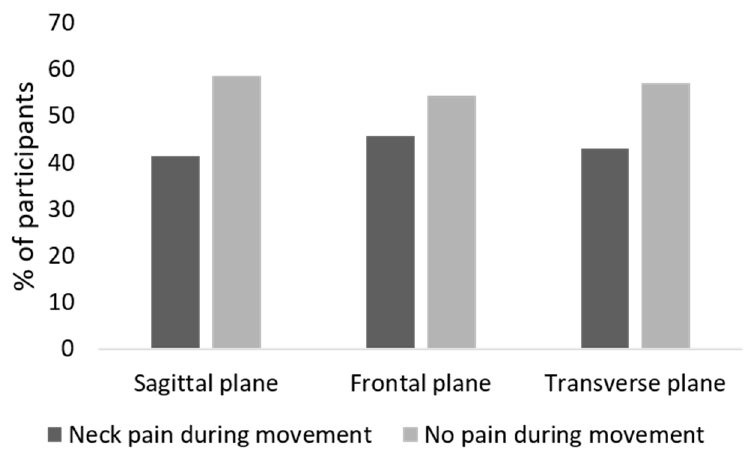
Figure 2. Self-reported neck pain during cervical motion in the three planes of motion. The correlation analysis revealed weak negative associations between PHQ-9 score and cervical ROM in all planes (Table 2, Figure 3); the higher the depressive symptoms,